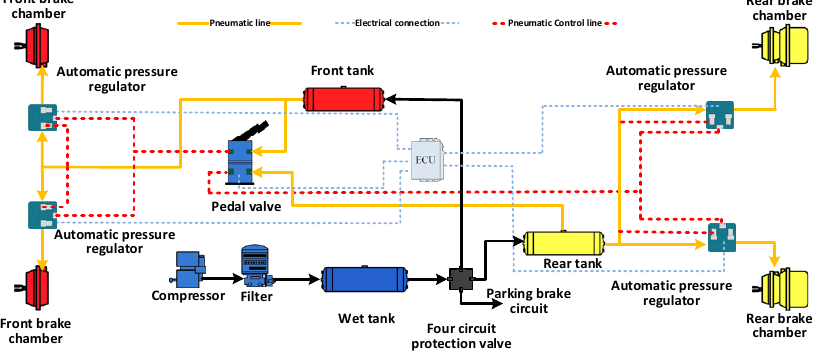
Figure 1. Principle drawing of the ECPBS in commercial vehicles.